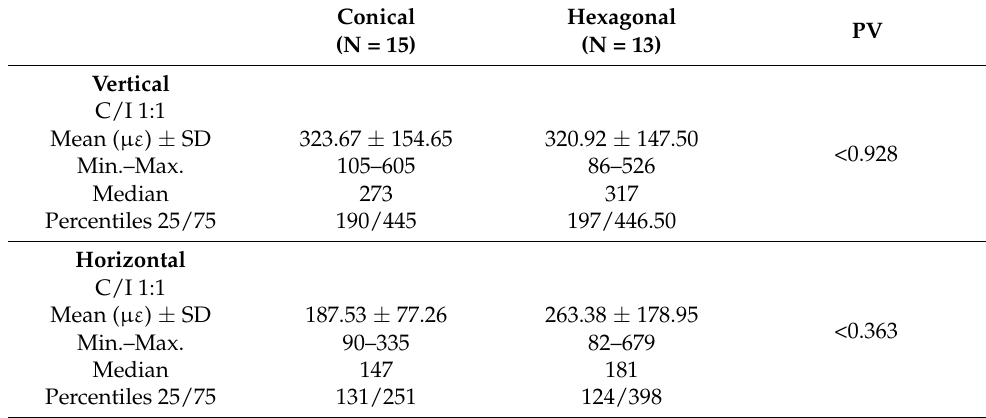
Table 6. Intragroup comparison of hexagonal and conical connection maximum values of the STI when C/I ratio is 1:1 and